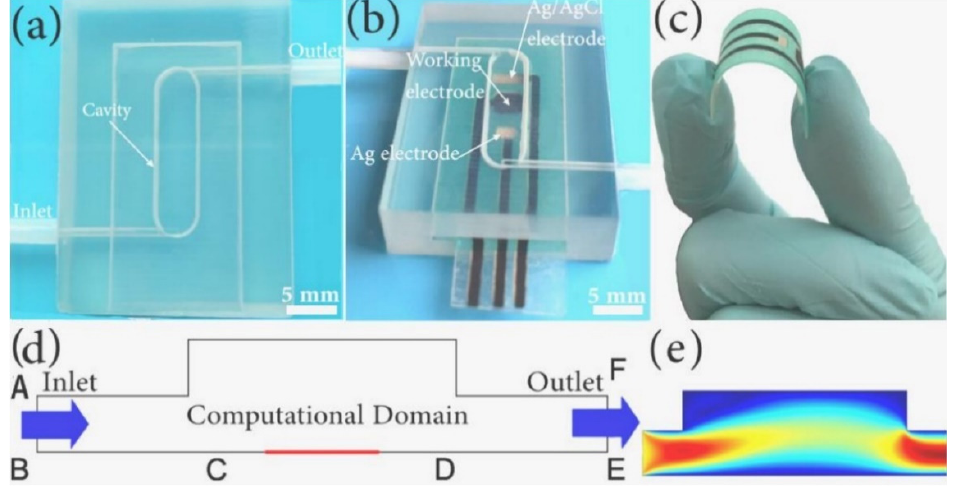
Figure 5. ( a , b ) Photographic images of the microfluidic device without and with the screen printed electrodes (SPE); ( c ) photograph of SPE; ( d ) the computational domain of microfluidic chip combined with work electrode; ( e ) the velocity outline of microfluidic cell. Figure adapted from Hong et al. [147]. Copyright (2016) American Chemical Society.